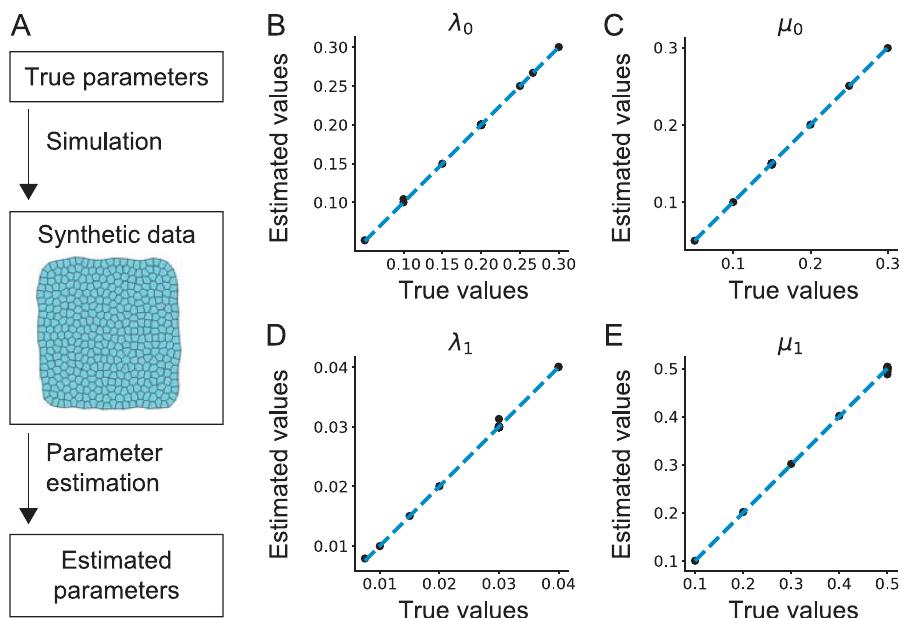
Fig 3. In silico validation of the parameter estimation method. (A) Schematic of a perfect model experiment. (B–E) Estimated values of parameters are plotted against their true values for λ 0 (B; the line tension), μ 0 (C; the anisotropy in the line tension), λ 1 (D; the spring constant of junction), and μ 1 (E; the anisotropy in the spring constant of junction). Estimated values of λ 0 and λ 1 were normalized by k and A 0 = 1.0 as l estimated value of q . A dashed line indicates y = x